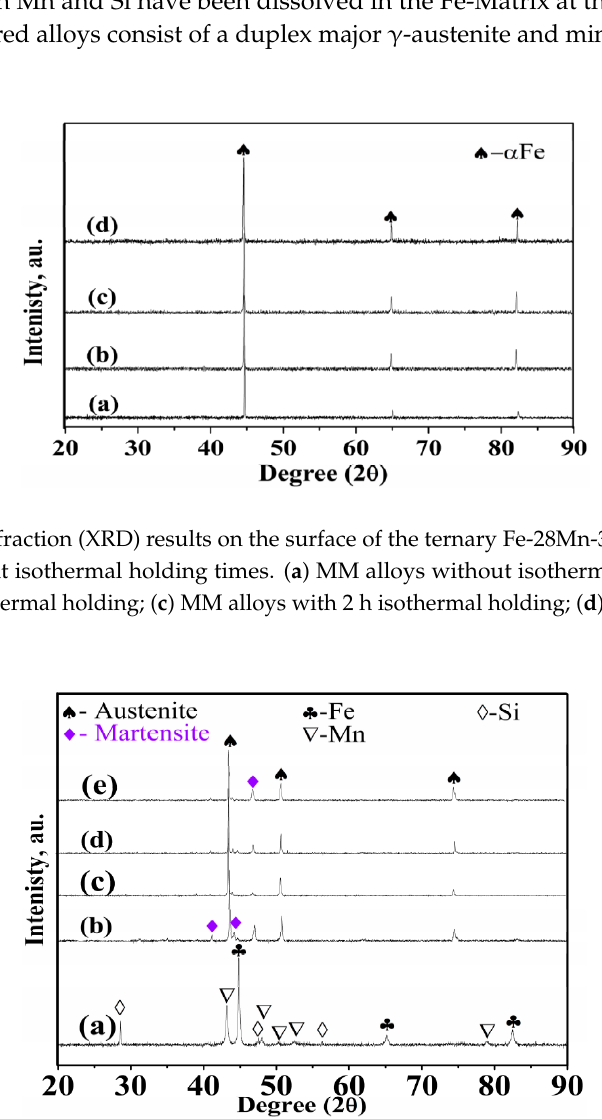
Figure 9. Morphology of the MM Fe-Mn-Si compacts sintered at 1200 °C for various isothermal holding times: ( a ) no isothermal holding; ( b ) 1 h; ( c ) 2 h; ( d ) 3 h.